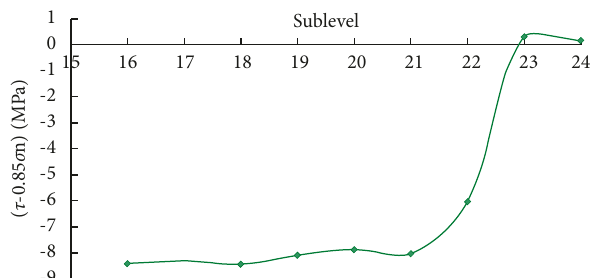
Figure 20: The sliding property of fault FC3 varies with mining depth.